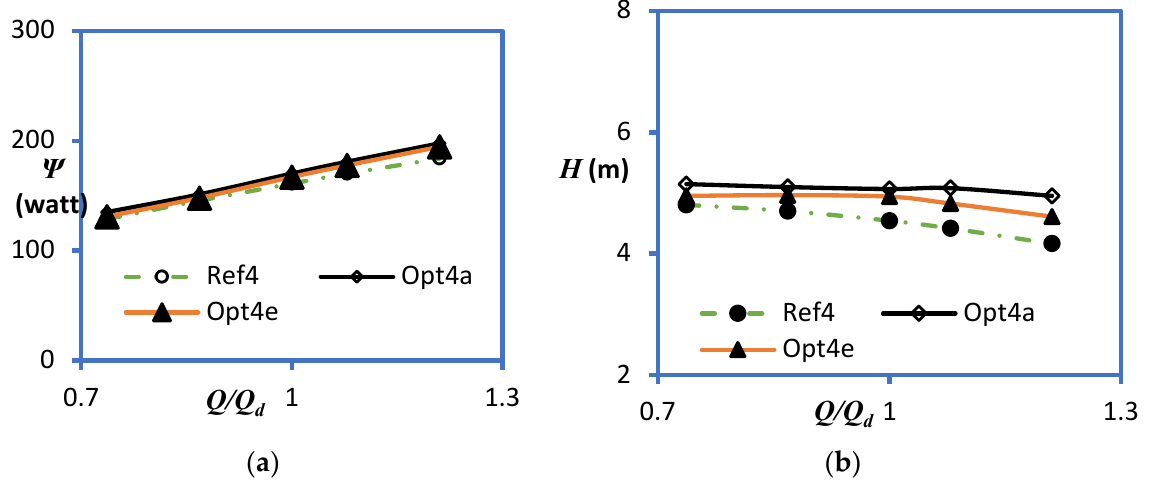
Figure 18. Pump performance comparison for oil C3: ( a ) Ψ versus Q/Qd and ( b ) H versus Q/Qd.